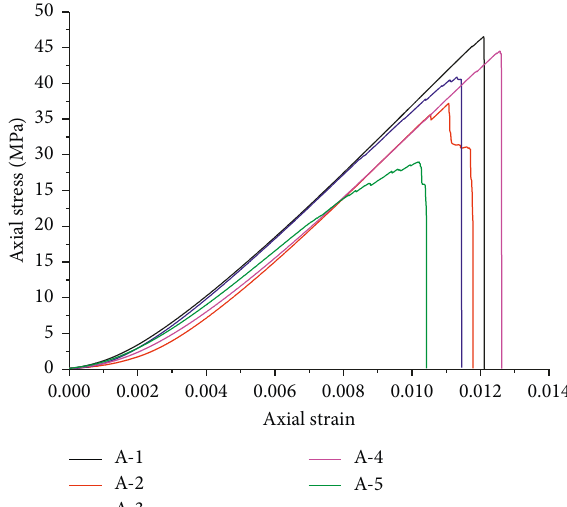
Figure 2: Uniaxial compressive stress-strain curves. Intact composite specimen, UCS = 46.55MPa 12.18%UCS = 44.52MPa Decrease by 4.37% 20.11%UCS = 40.88MPa Decrease by UCS = 31.79MPa Decrease by UCS = 28.99MPa Decrease by 37.72%